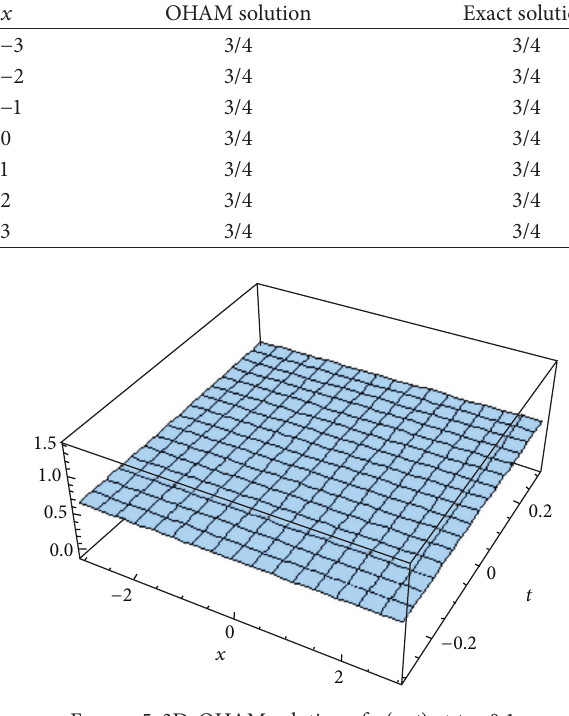
Figure 5: 3D, OHAM solution of 𝜇(𝑥,𝑡) at 𝑡 = 0.1 .